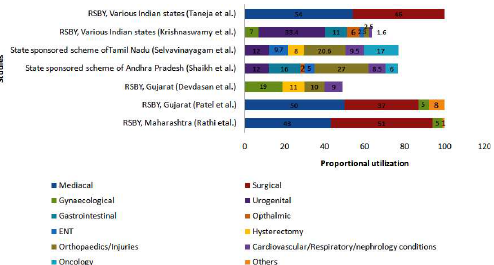
Fig 2. Procedure/speciality-wise utilization under publicly financed health insurance schemes in Indian